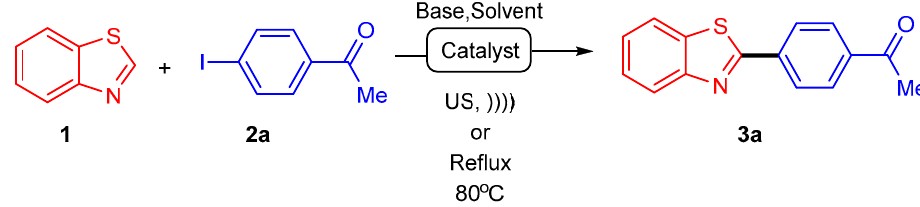
Table 1. The reaction conditions for Pd@Chitosan catalysis of the C-H arylation of benzothiazole.